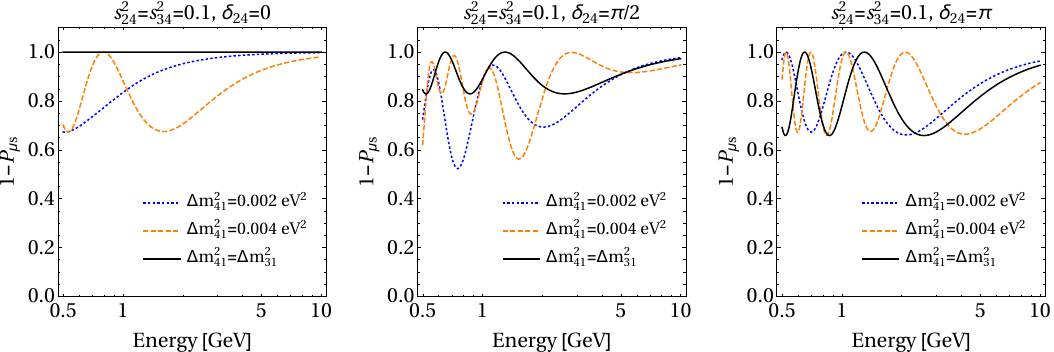
Figure 1 . Oscillation probability in the (cid:23) (cid:22) ! (cid:23) s channel, in vacuum. The di(cid:11)erent panels corre- spond to di(cid:11)erent values of the new CP-violating phase (cid:14) 24 , while the di(cid:11)erent lines shown in each panel correspond to di(cid:11)erent values of the active-sterile mass splitting (cid:1) m 2 end. The rest of the oscillation parameters have been (cid:12)xed to: (cid:1) m 2 0 : 5 ; sin 2 2 (cid:18) 13 = 0 : 084 ; and sin 2 (cid:18) 24 = sin 2 (cid:18) 34 = 0 :